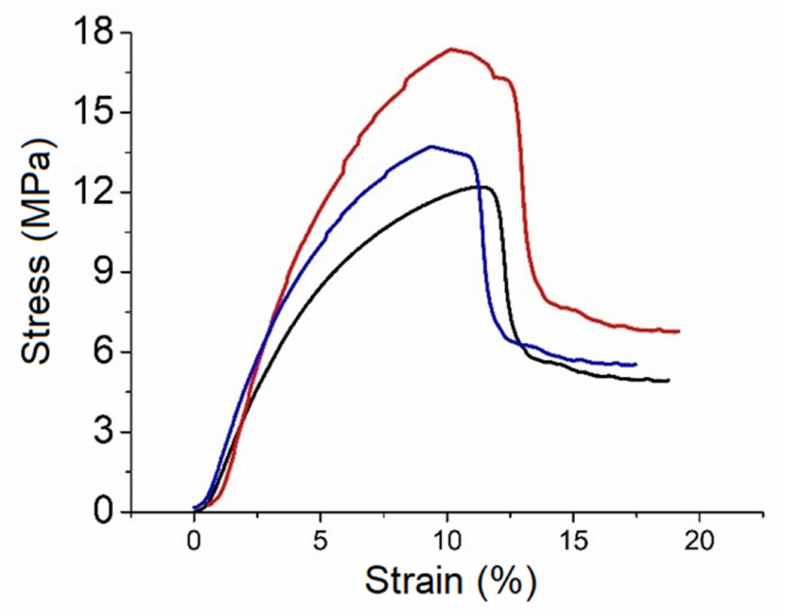
Figure 6. Stress-strain curves of three